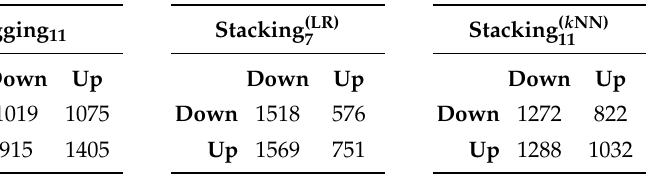
Table 10. Confusion matrices of Averaging 11 , Bagging 11 , Stacking (LR) CNN-BiLSTM as base model for BTC